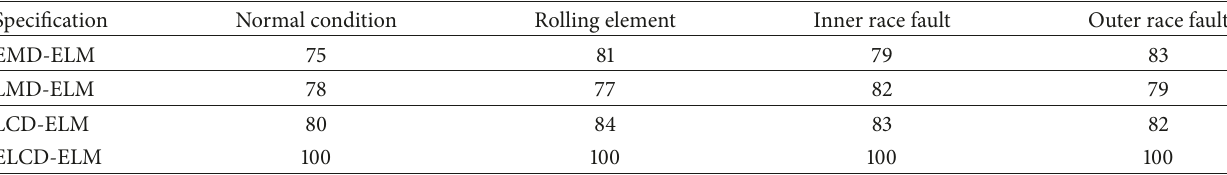
Table 1: Test accuracy.